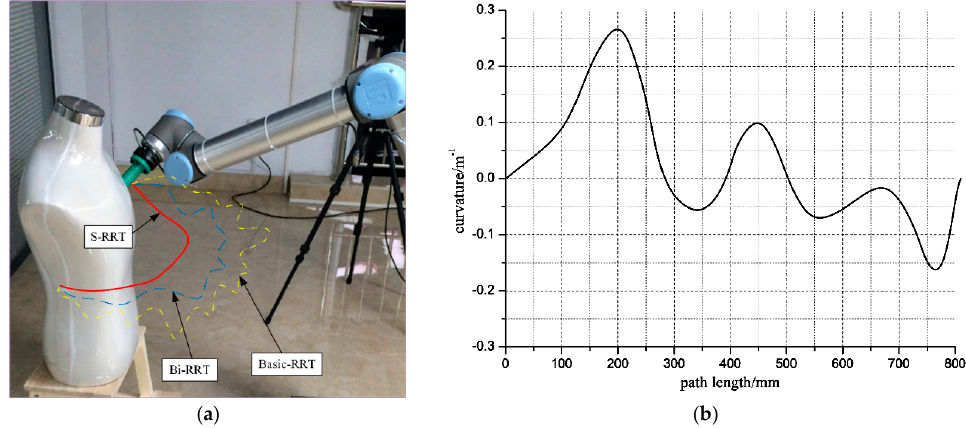
Figure 6. Path sequence with the S-RRT algorithm in static obstacle avoidance. ( a )–( f ) represent different states of the manipulator and static obstacle at each moment.